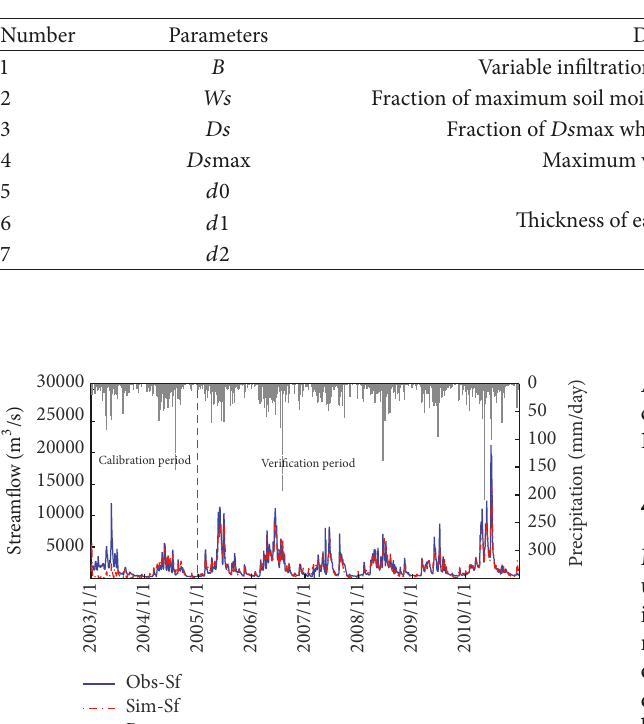
Table 1: VIC model calibrated parameters and calibrated values in Ganjiang River basin.